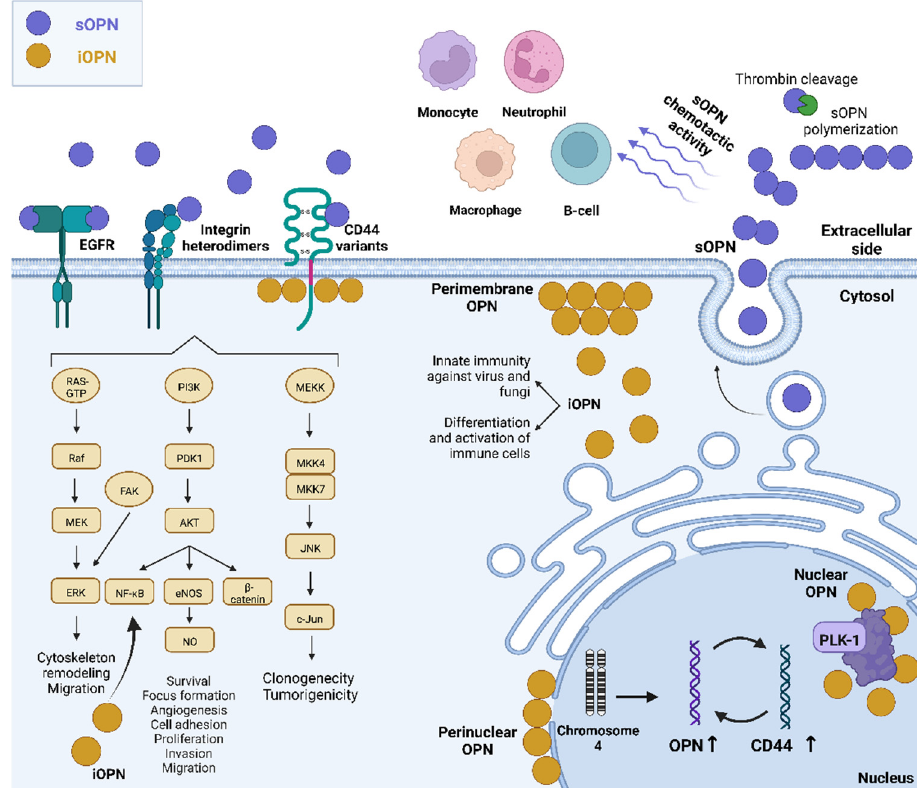
Figure 3 . Roles and mechanisms of osteopontin in cancer cells. Osteopontin is a highly expressed protein that acts through several mechanisms in cancer cells. Secreted OPN can regulate PI3K/AKT, MAPK, and JNK intracellular signaling pathways through interacting with its known membrane receptors, CD44 variants, integrins, and/or EGFR, resulting in the activation of a pro-tumorigenic phenotype, including increased survival, proliferation, clonogenicity and capacity of migration and invasion. Extracellular OPN has been extensively associated with the immune system once this protein mediates chemoattraction of cells, such as monocytes, neutrophils, and lymphocytes, as well as macrophage accumulation in diverse diseases, including in tumor microenvironments. This variety of extracellular roles is due to several modifications, such as post-translational mechanisms, polymerization, and thrombin cleavage. Intracellular OPN has been localized in the perimembranous and perinuclear regions regulating the expression of NF-kB, cytoskeleton remodeling through the CD44 receptor, and activation and differentiation of immune cells in responses against viruses and fungi. Besides cytoplasmic OPN, it has been observed a nuclear localization for this protein where it accumulates and is associated with the presence of Plk-1 and chromatin condensation. Once OPN has been associated with a poor prognosis and acquisition of pro-tumorigenic features, molecules aiming the regulation of OPN have been the focus of studies, such as genistein, which inhibits sOPN expression, leading to reduces colony formation rates, migration, and invasion. sOPN: secreted